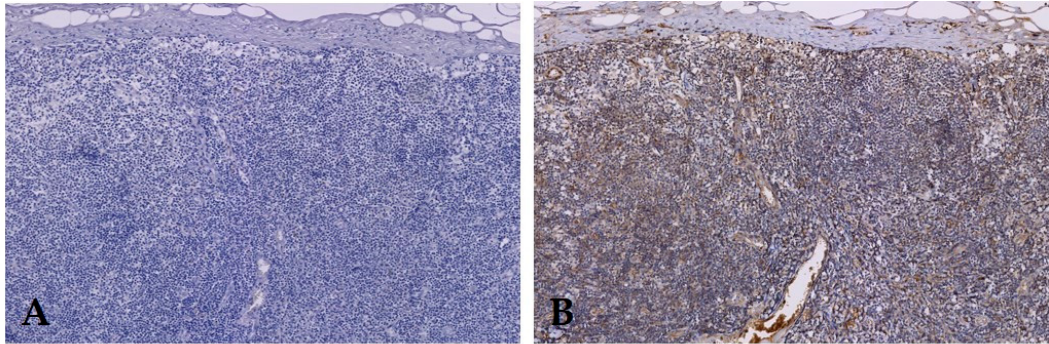
Figure 3. Lymph node without metastasis without ( A ) EGFR expression, but with ( B ) VEGF expression. Original magnification 200×.